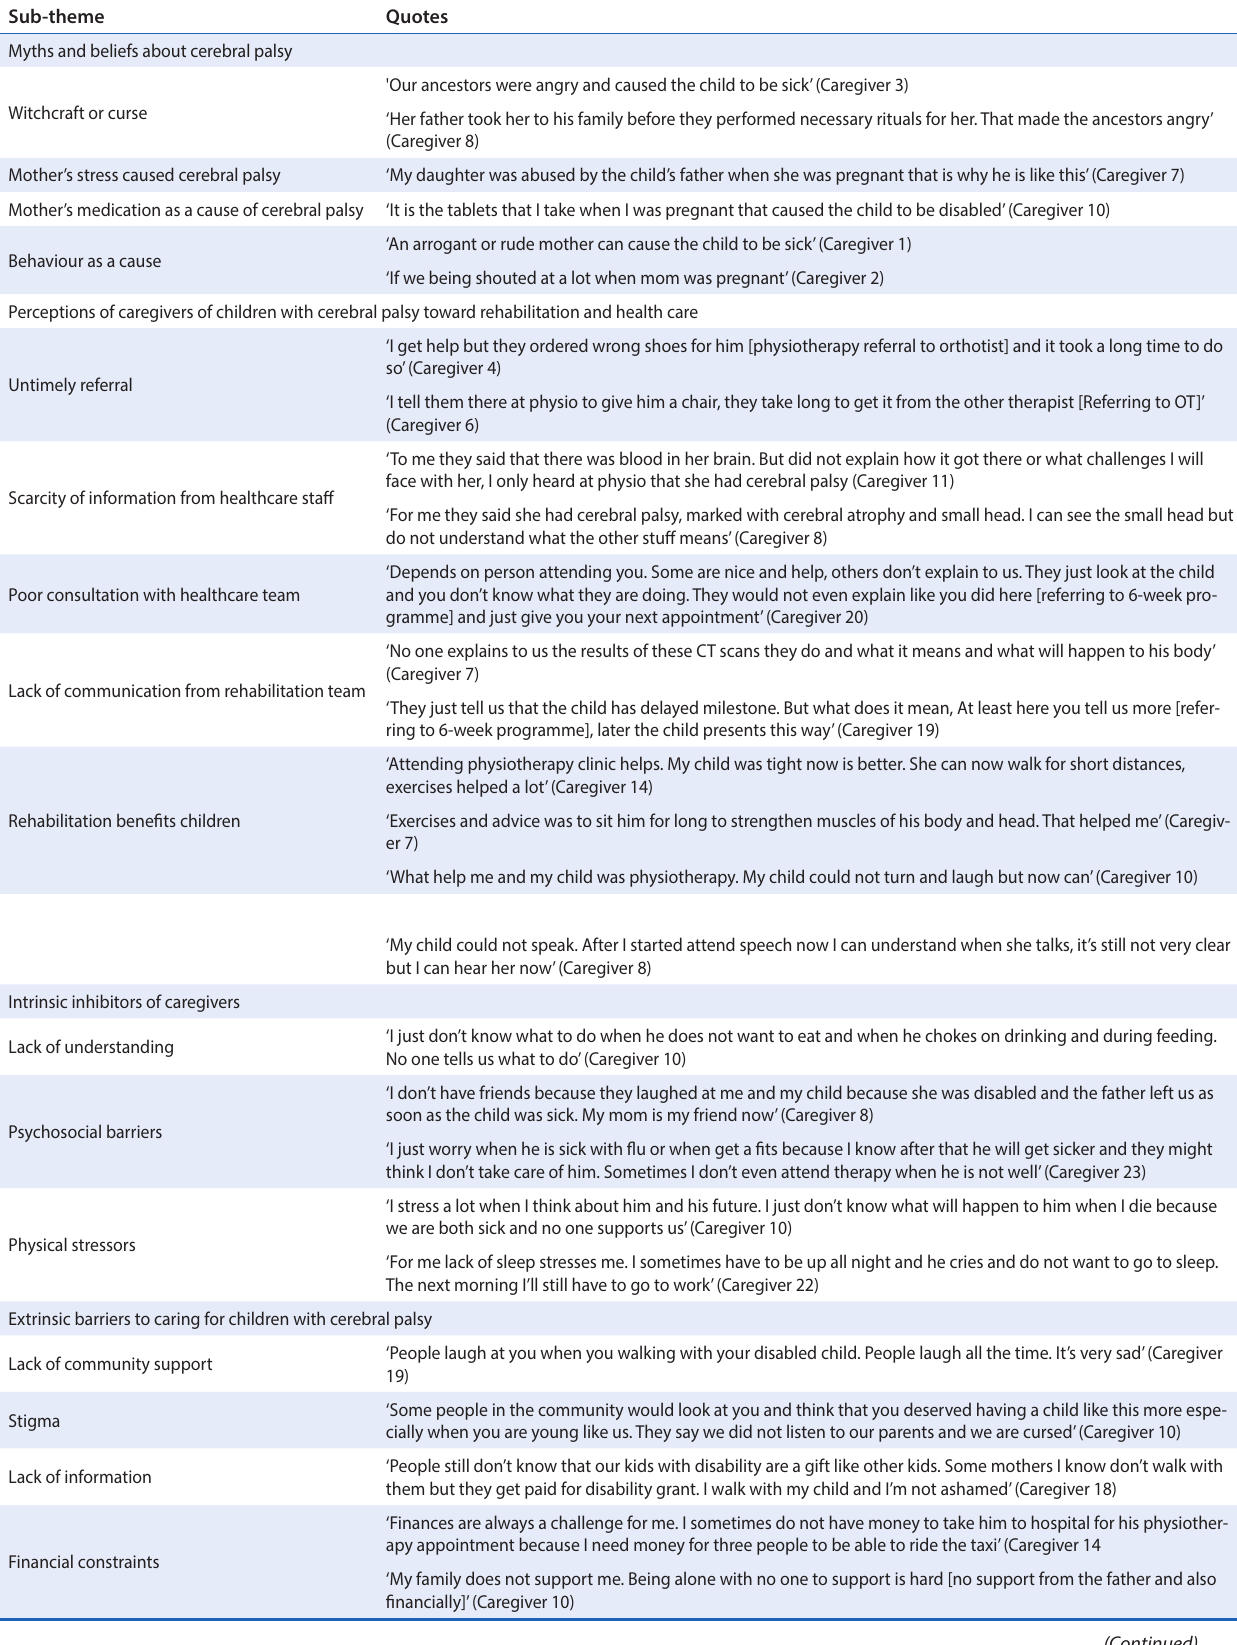
Table 3: Thematic representation of caregivers’ understanding of CP and their challenges to rehabilitation Sub-theme Quotes Myths and beliefs about cerebral palsy Witchcraft or